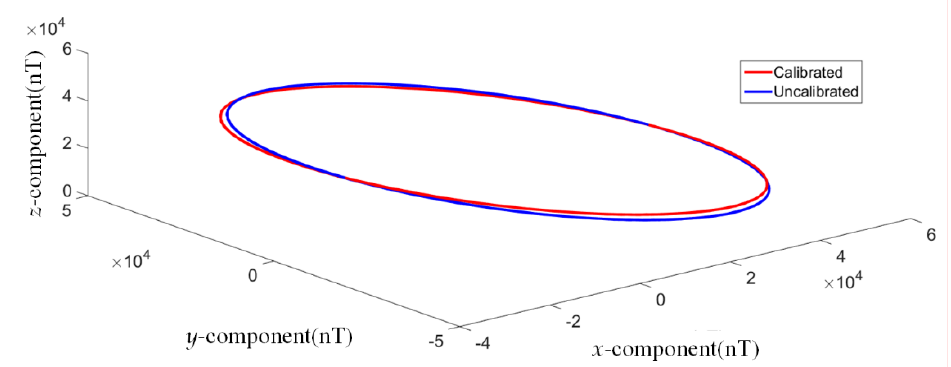
Figure 7. Trajectory coincidence after calibration.